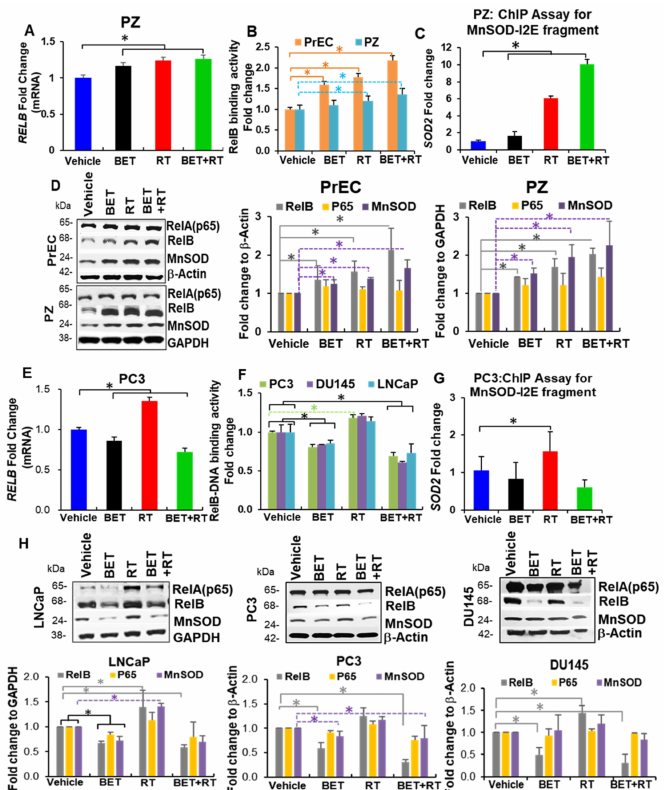
Figure 4. RelB expression determines radioprotector effect of BET in non-PCa cells and radio-killing effect of BET. PZ cells were treated with BET and/or RT (2 Gy) for 24 h. NF-kB transcription factor family expression levels and function were measured. ( A ) RT-PCR of RelB. ( B ) RelB binding activity. ( C ) Chip assay with RelB antibody to I2E promoter of MnSOD. ( D ) Representative Western blots and quantitative analysis of protein expression for PrEC cells and PZ cells. * p -value ≤ 0.05 when compared with vehicle. PCa cells (LNCaP, PC3, DU145) were treated with either BET and/or RT (2 Gy) for 24 h. NF-kB transcription factor family expression levels and function were measured. ( E ) RT-PCR of RelB of PC3 cells. ( F ) RelB binding activity of PCa cells. ( G ) Chip assay with RelB antibody to I2E promoter of MnSOD of PC3 cells. ( H ) Representative Western blots and quantitative analysis of protein expression of PCa cells. n = 3. * p -value ≤ 0.05 when compared with